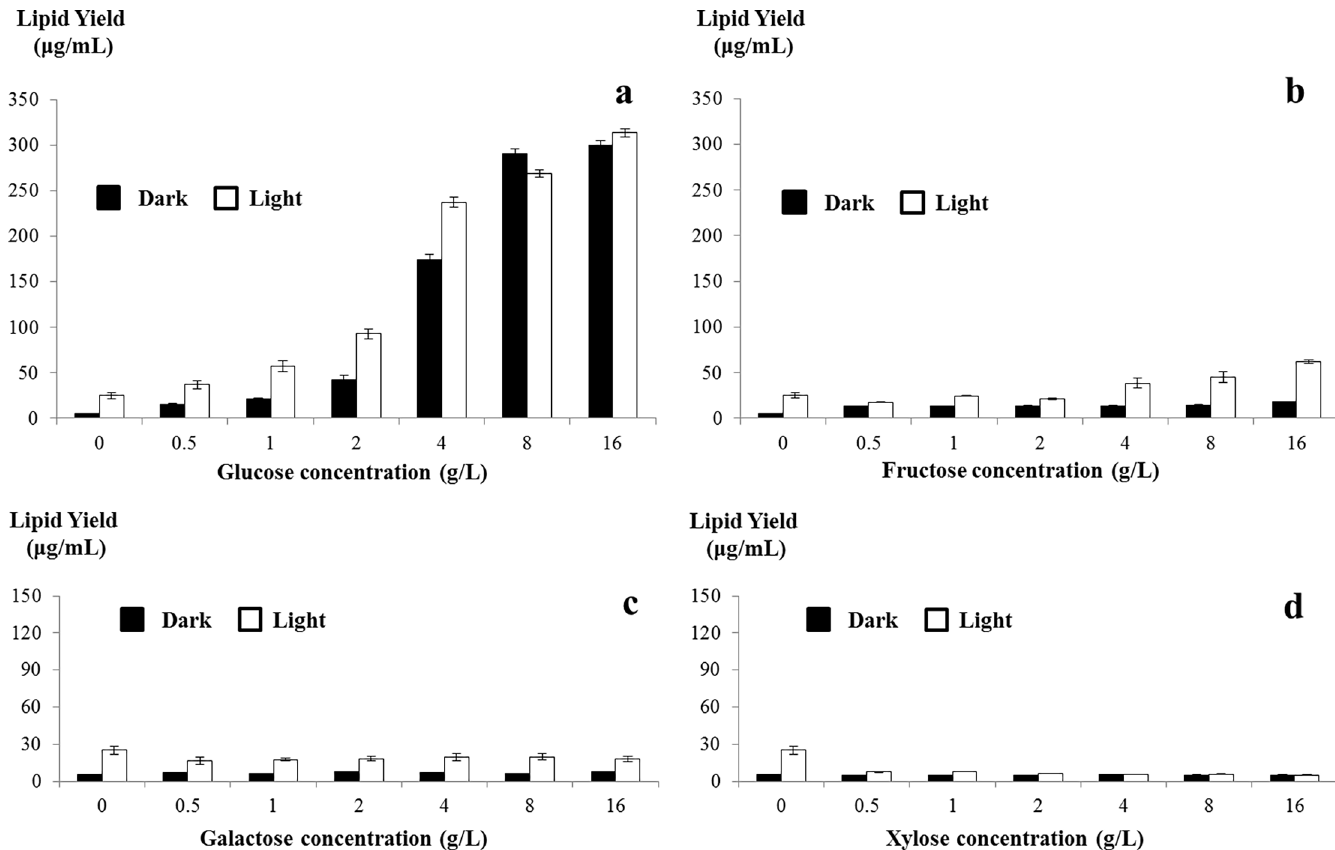
Fig 5. Lipid yield of Chlorella sorokiniana UTEX 1230 in monosaccharide-supplemented medium. Lipid yield of C . sorokiniana UTEX 1230 cells collected from monosaccharide-supplemented medium after 7 days culture was determined by the sulfo-phospho-vanillin method. Lipid yield per mL of culture was calculated. X- and y-axes on the graph correspond to monosaccharide concentration and lipid yield (μg/mL), respectively. a, b, c and d show the lipid yield of cells cultivated in glucose-, fructose-, galactose- and xylose-supplemented media, respectively. Data shown as mean +/-SD, n = 3. Black bar: dark conditions; white bar: light conditions.